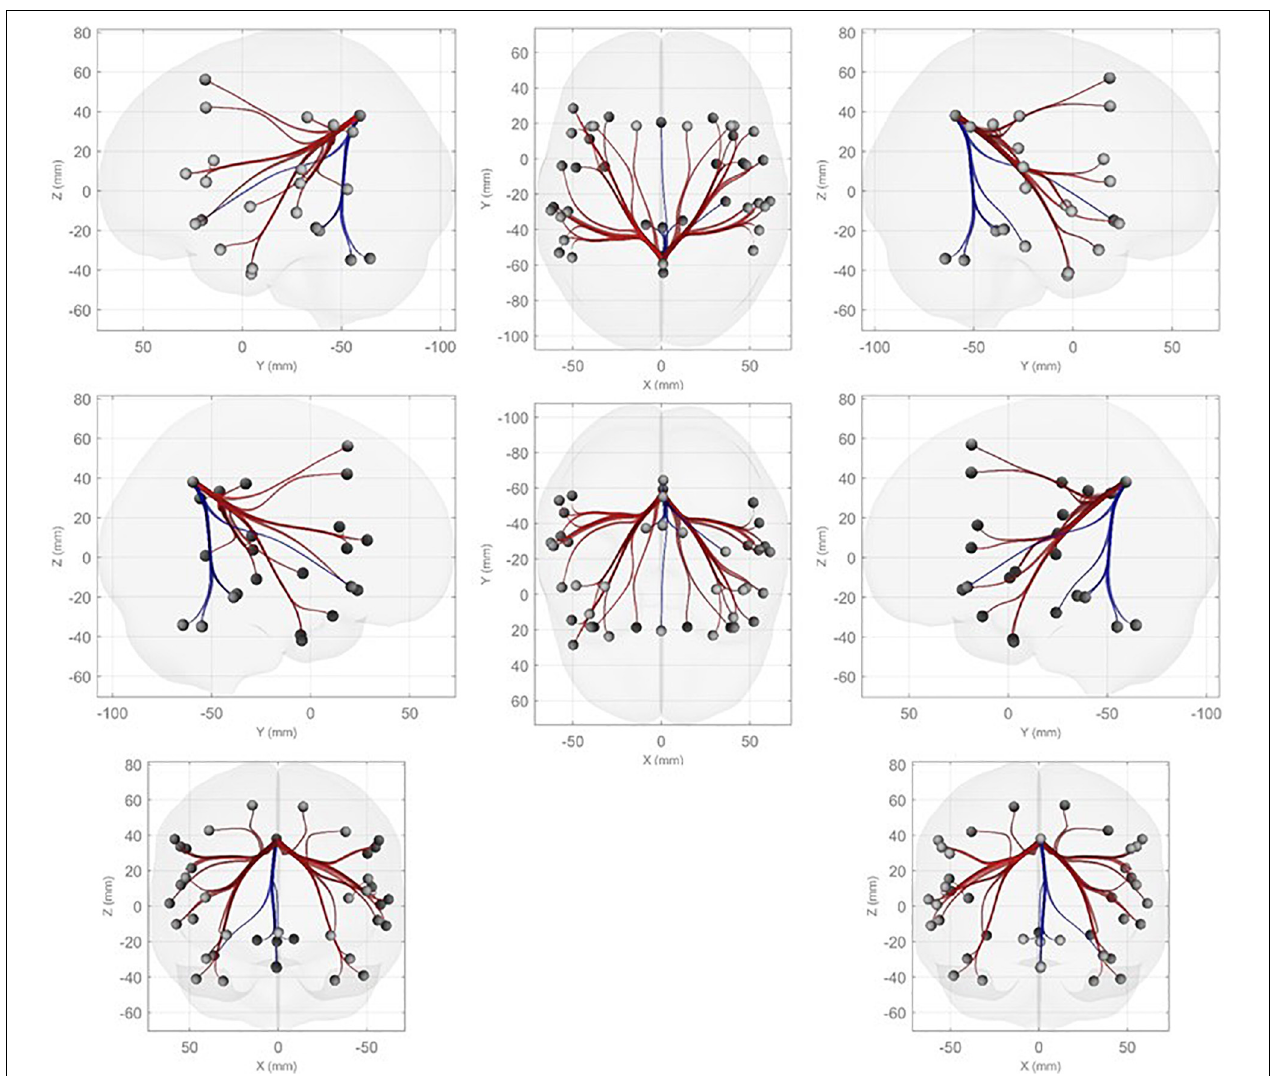
FIGURE 4 | ROI-to-ROI functional connectivity analysis with the precuneus as the seed. Connectivity that was increased (decreased) during the performance condition compared with the resting condition is indicated in red (blue) based on the criteria of p -FDR <